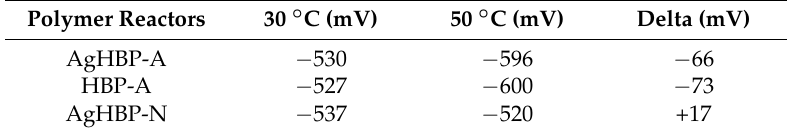
Table 1. Reduction potentials with substrate desorbing from all the prepared polymer reactors.